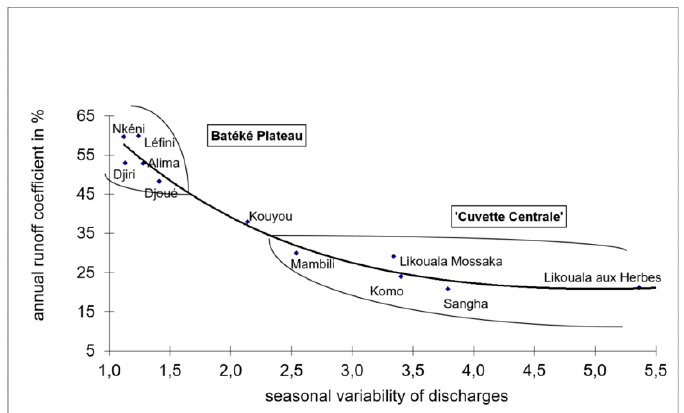
Figure 20. Hydrological classification of the Congolese tributaries of the Congo River [10].